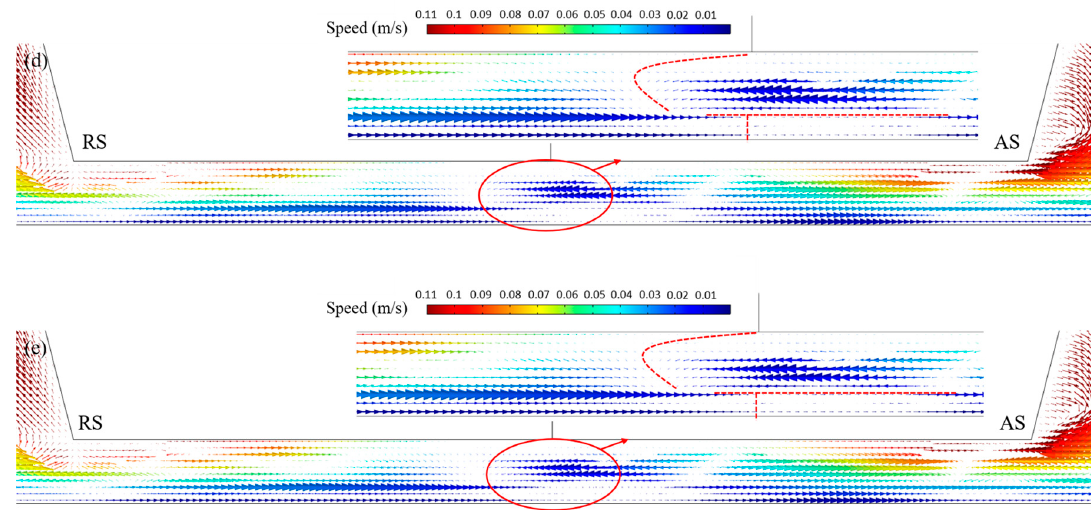
Figure 19. Flow behavior of plastic metal at different temperatures ( a ) No. 1; ( b ) No. 2; ( c ) No. 3; ( d ) No. 4; ( e ) No. 5.